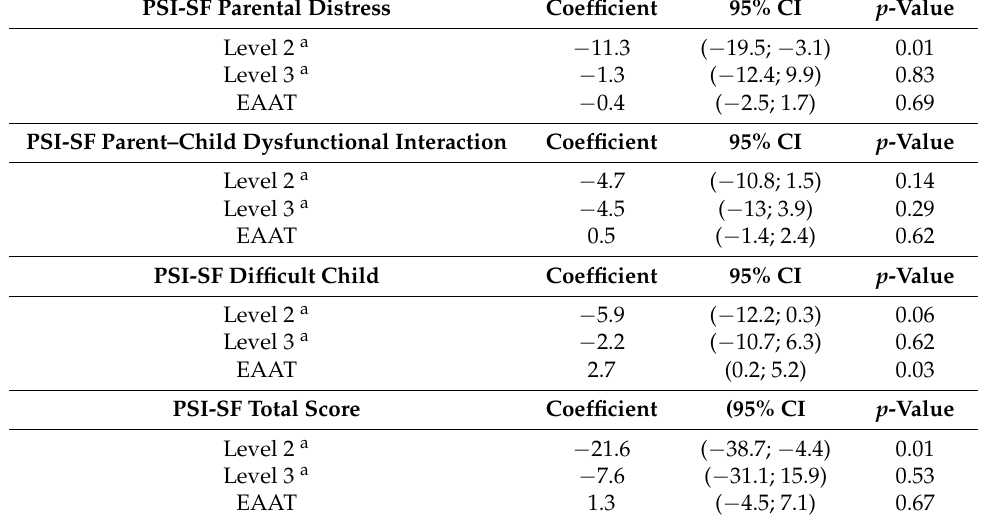
Table 4. Association between the EAAT and the PSI-SF.